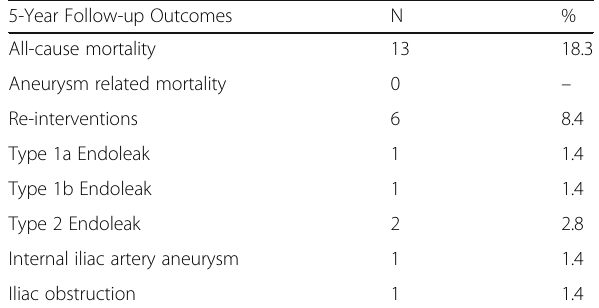
Table 4 5-year follow-up